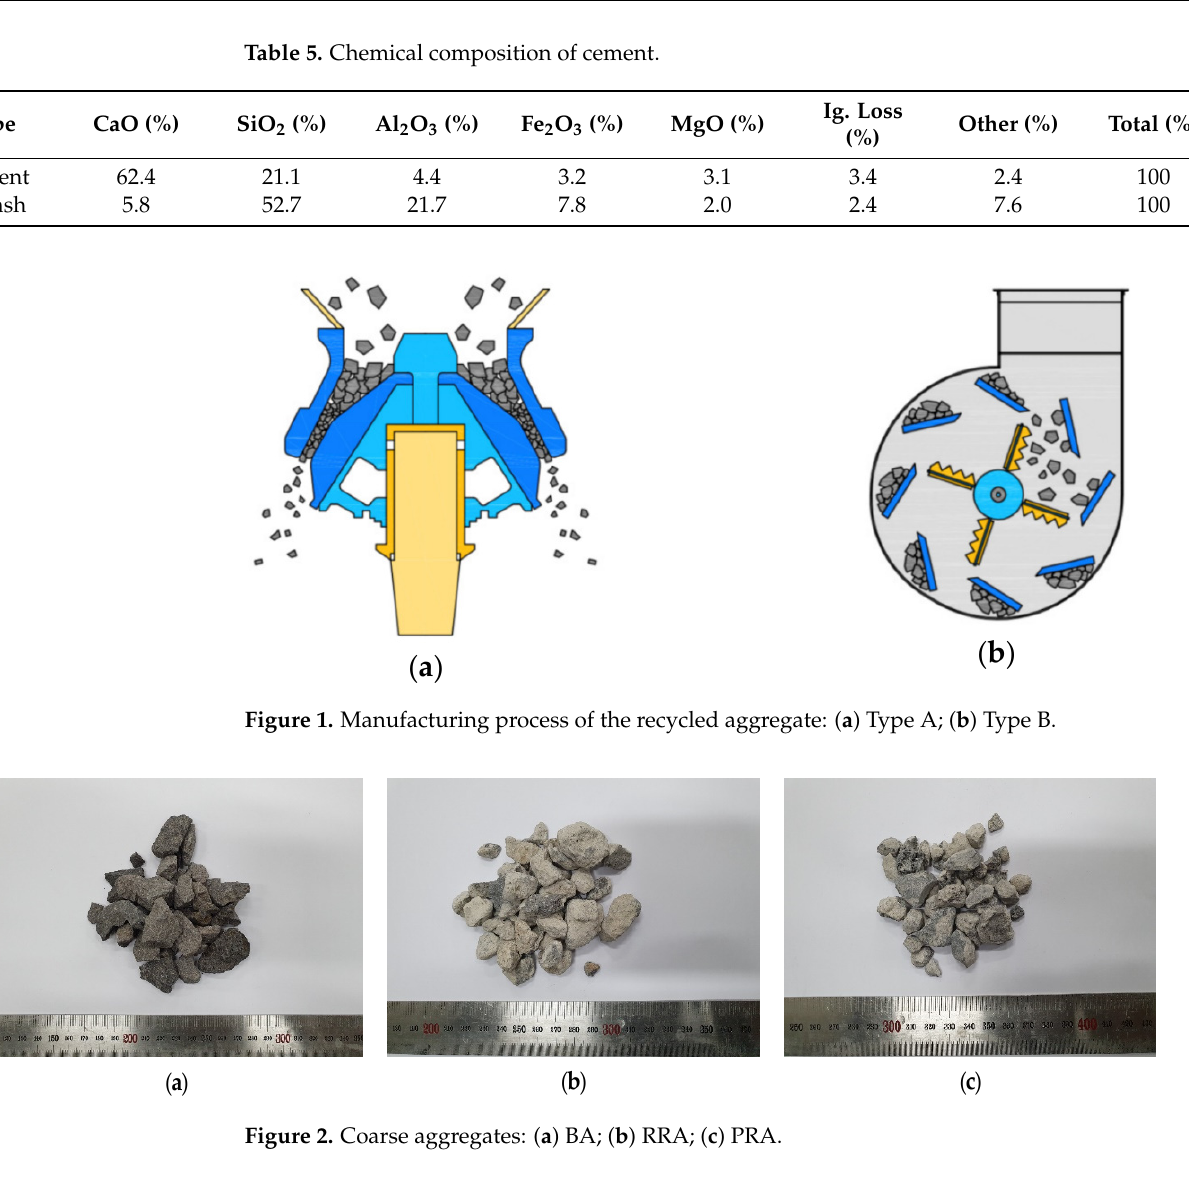
Table 3. Physical properties of cement. Table 4. Physical properties of fly ash.t. Table 4. Physical properties of fly ash.t. Table 4. Physical properties of fly ash.t.